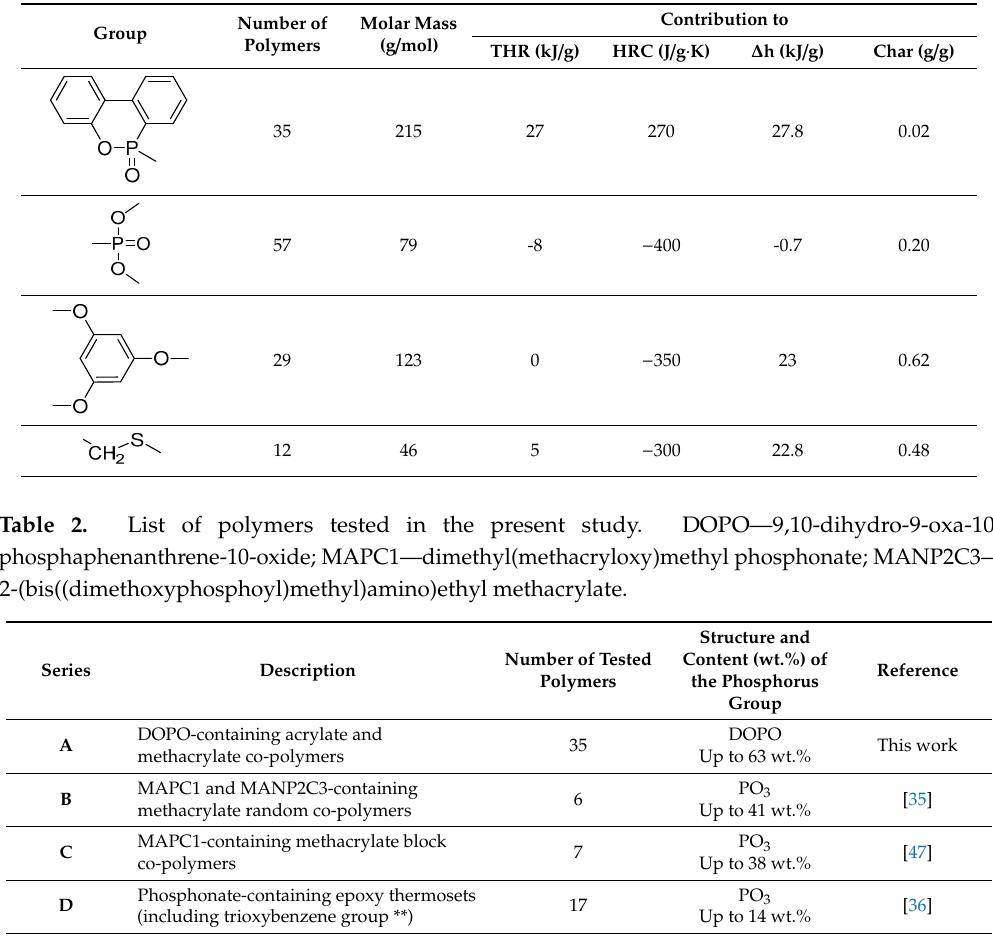
Table 2. List of groups studied in the present work and their estimated contributions to flammability. HRC—heat release capacity.